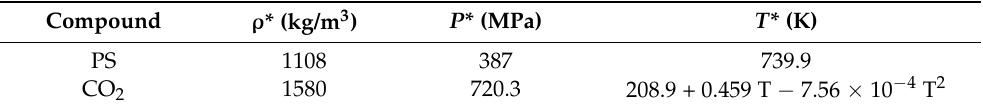
Table 7. Characteristic parameters of PS and CO 2 used in SLEOS.